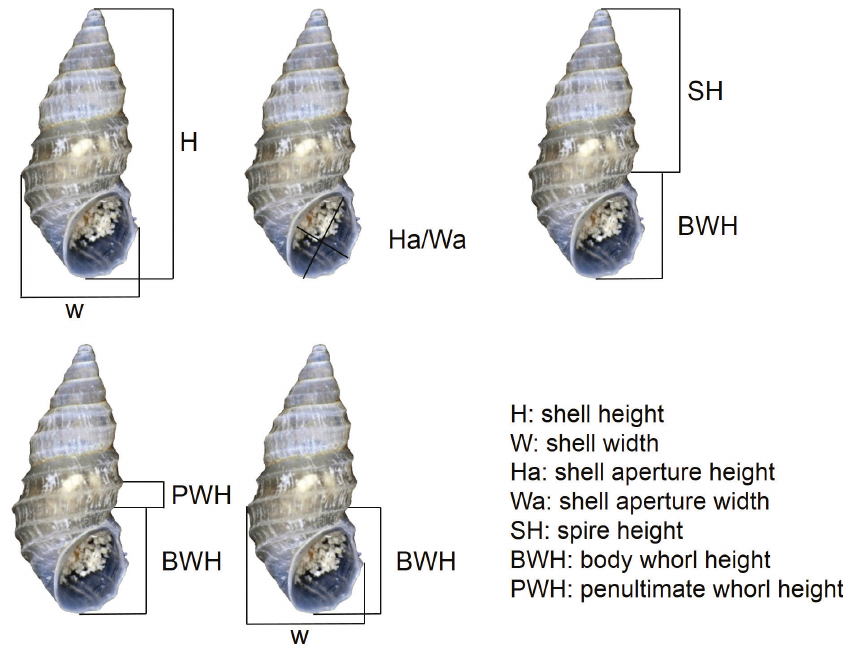
Figure 3. External morphological measurements taken in specimens of Dianella schlickumi and Dianella thiesseana.